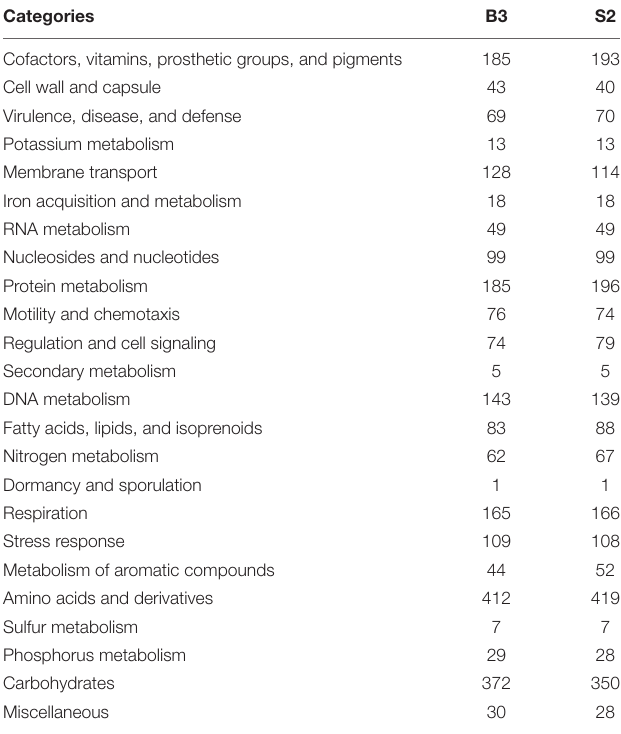
TABLE 1 | Subsystem category enrichment analyses of the B3 and S2